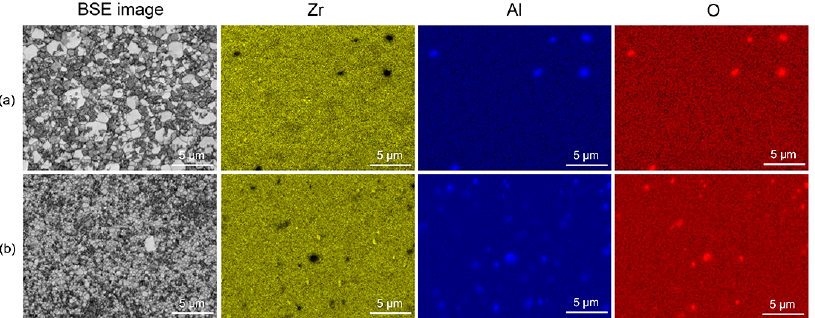
Figure 3. EDS images of the SM- ( a ) and SLA-fabricated ( b ) Y-TZP ceramics (magnification = 5000×; scale bar = 5 μ m). BSE, backscattered electron.